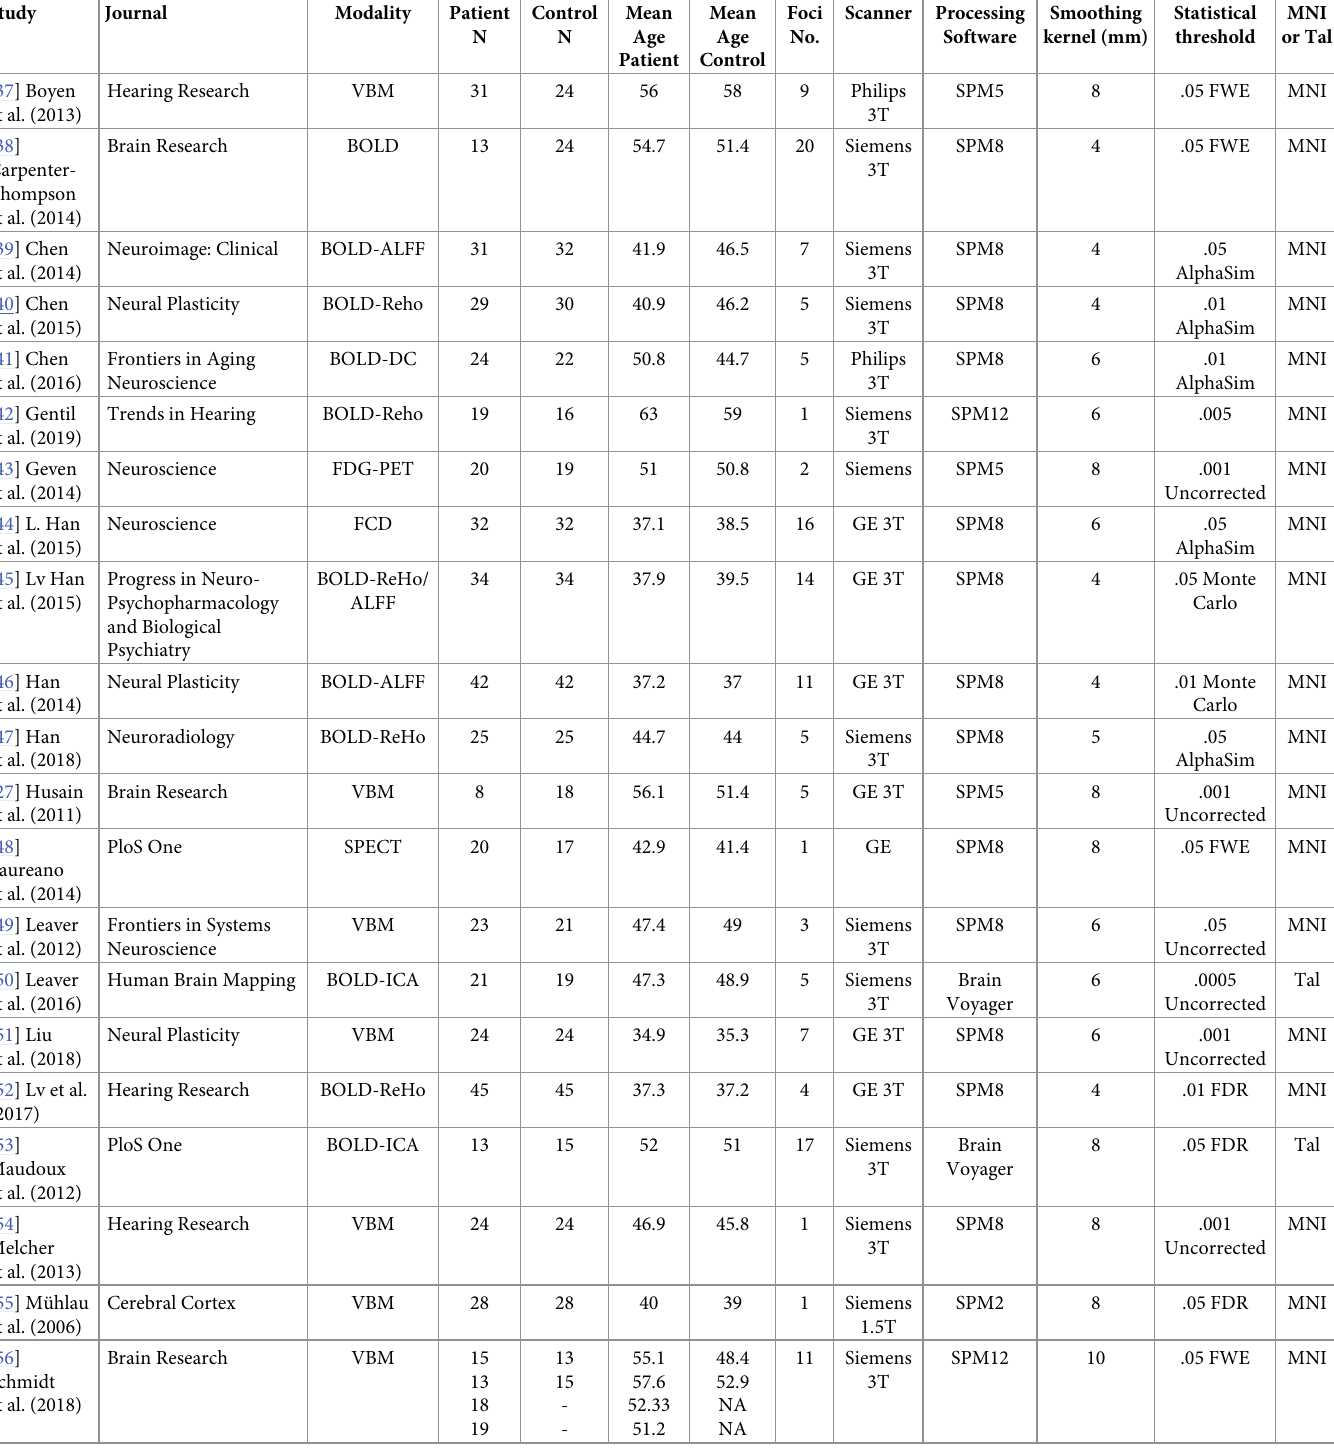
Table 1. Studies included in